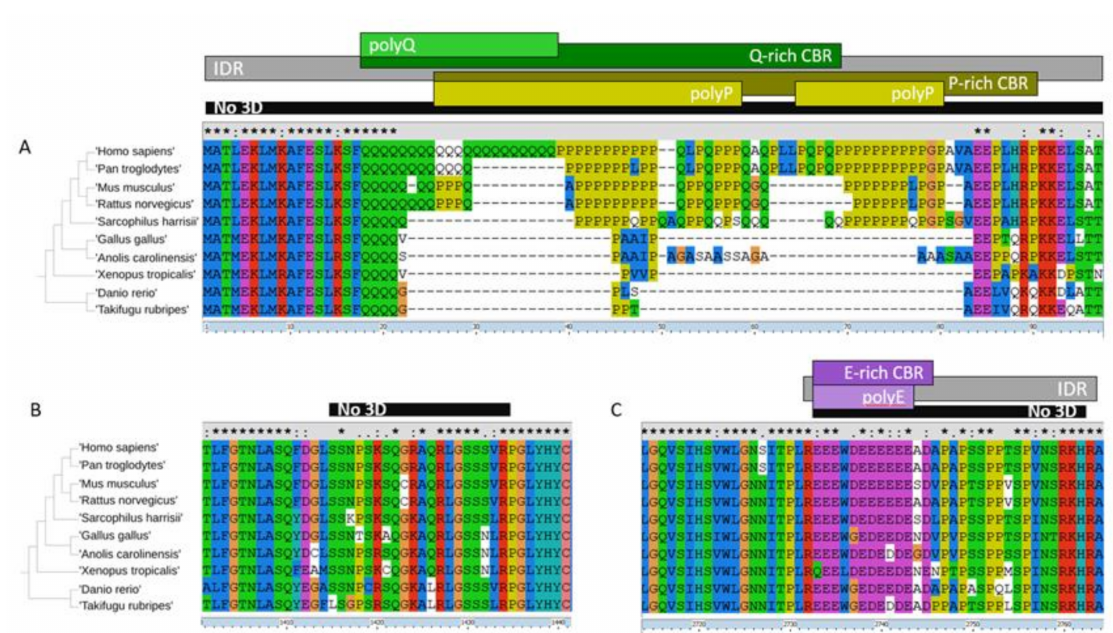
Figure 3. LCRs in HTT. Fragments of a multiple sequence alignment of HTT orthologs in 10 species. All four polyX detected in HTT are in the fragments shown. The multiple sequence alignment was represented using ClustalX [21]. ( A ) Human HTT (P42858) positions are 1–95 (not resolved in the 3D structure). ( B ) Positions 1318–1358, between the cyan and the orange domain (Figures 1 and 2). ( C ) Positions 2613–2664, within the blue domain. Coordinates shown are from the alignment. No coiled coils (CCs) were detected for HTT orthologs. Sequence identifiers and LCR coordinates and alignments are available as Supplementary Files.